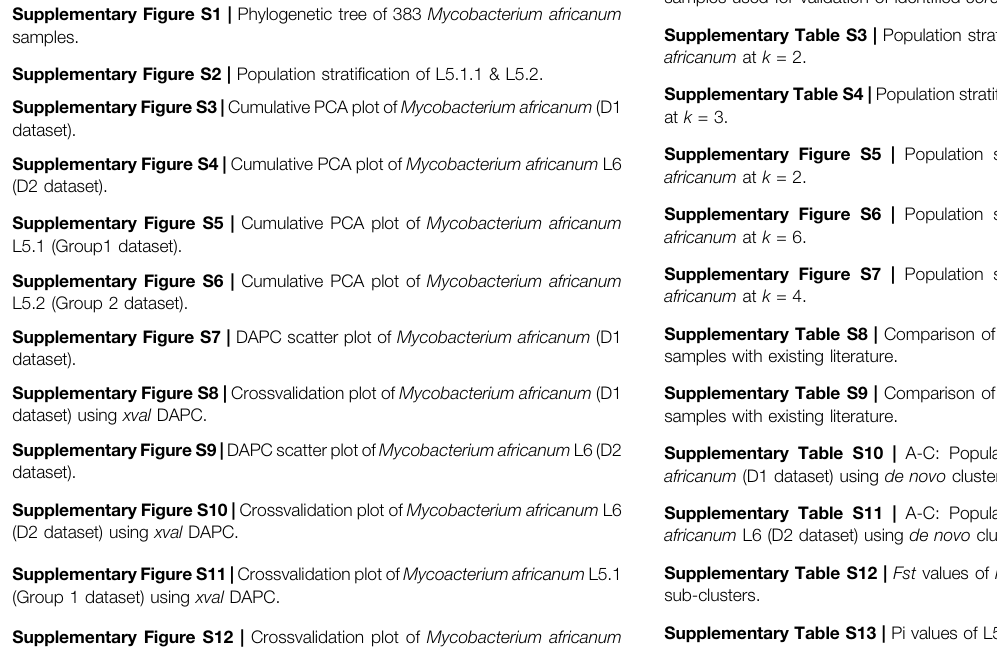
Supplementary Table S13 | Pi values of L5 and l6 (sub)clusters (obtained using STRUCTURE tool). Supplementary Table S14 | Detailed list of L6-cluster-speci fi c SNPs. Supplementary Table S15 | Detailed list of L5-cluster-speci fi c